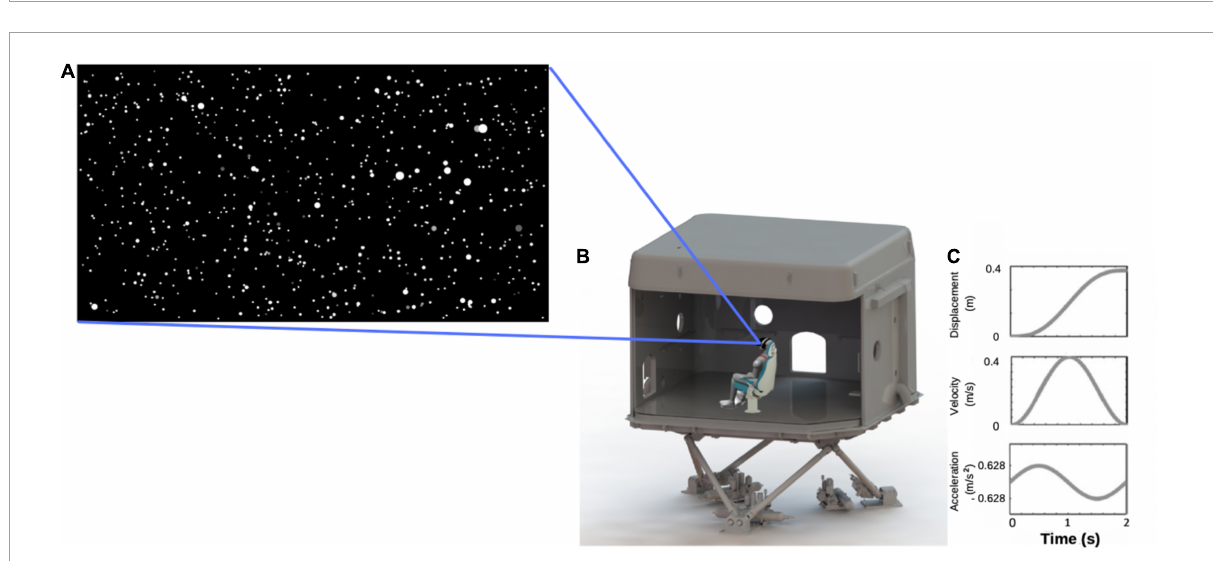
FIGURE2 (A) Screen capture of the starfield viewed by participants; (B) illustration of a participant wearing a head-mounted display, seated in a chair located within the laboratory that was mounted on top of the 6-degree-of-freedom hydraulic hexapod motion platform; (C) motion profile for one